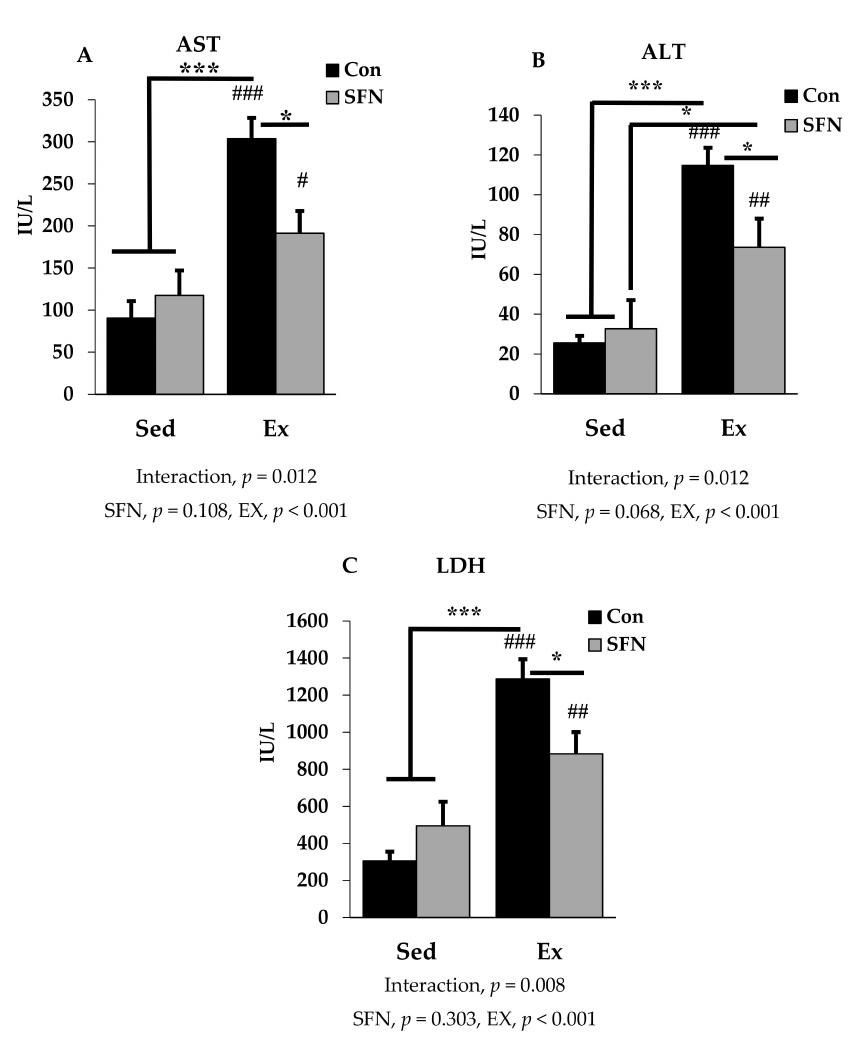
Figure 2. Plasma enzyme level comparison between the sedentary (Sed) and exercise (Ex) groups, with (sulforaphane; SFN) or without (control; Con) supplement. Figure 2 ( A – C ) represent aspartate aminotransferase (AST); alanine aminotransferase (ALT) and lactate dehydrogenase (LDH) levels in plasma. ### p < 0.001, ## p < 0.01, # p < 0.05 as compared to the sedentary control. *** p < 0.001, * p < 0.05. Interaction of SFN and Ex written as “Interaction”. Data are presented as mean ±